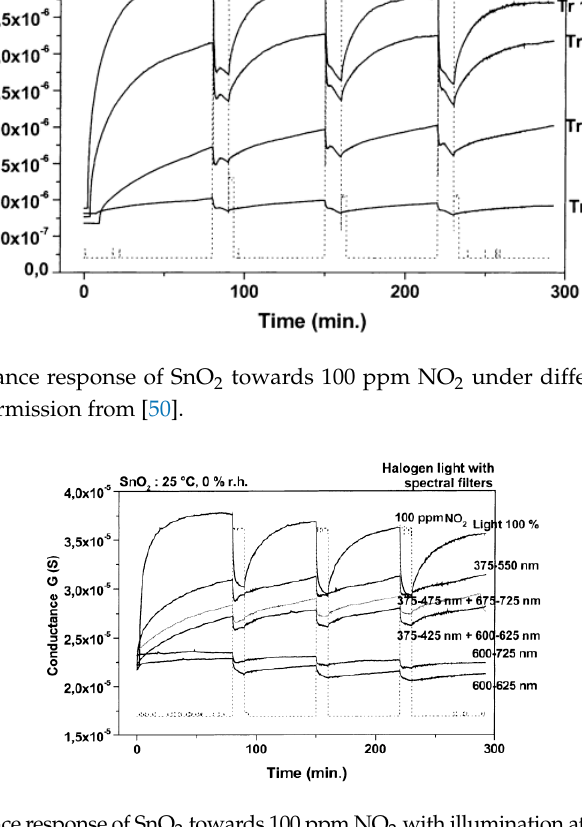
Figure 14. Conductance response of SnO 2 towards 100 ppm NO 2 with illumination at different wavelengths. Reproduced with permission from [50].